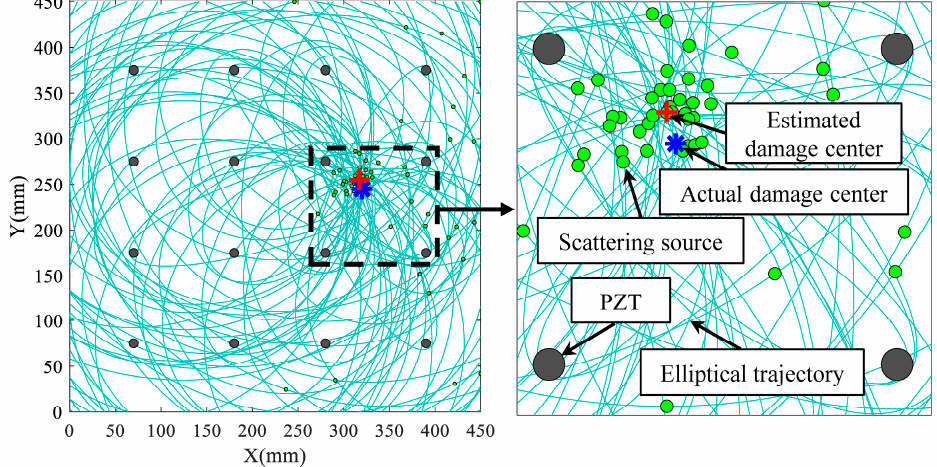
Figure 11. Distribution of scattering sources on the elliptical trajectory. The Gaussian kernel probability density distribution (PDD) function described the scattering sources distribution. Figure 12 shows the quantification results of damage with different sizes, which were enlarged gradually in steps of 4 mm in diameter at one posi-